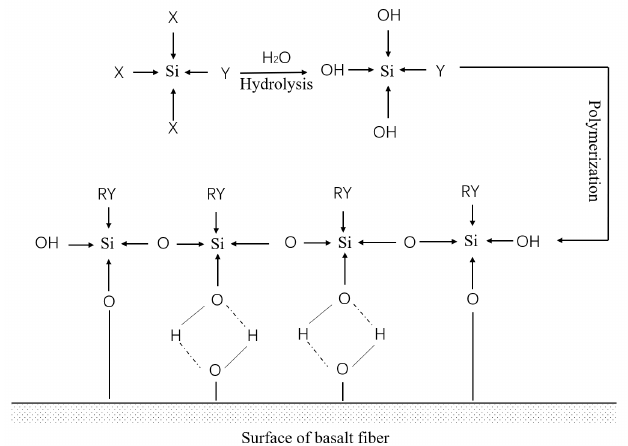
Figure 2. Flow chart of low temperature evaporation residue.